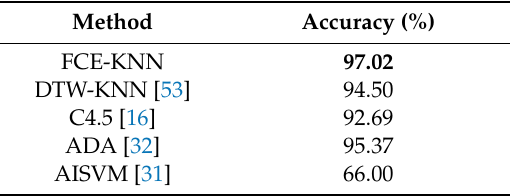
Table 8. Accuracy comparison between FCE-KNN and other algorithms for identifying content type of encrypted network flows.